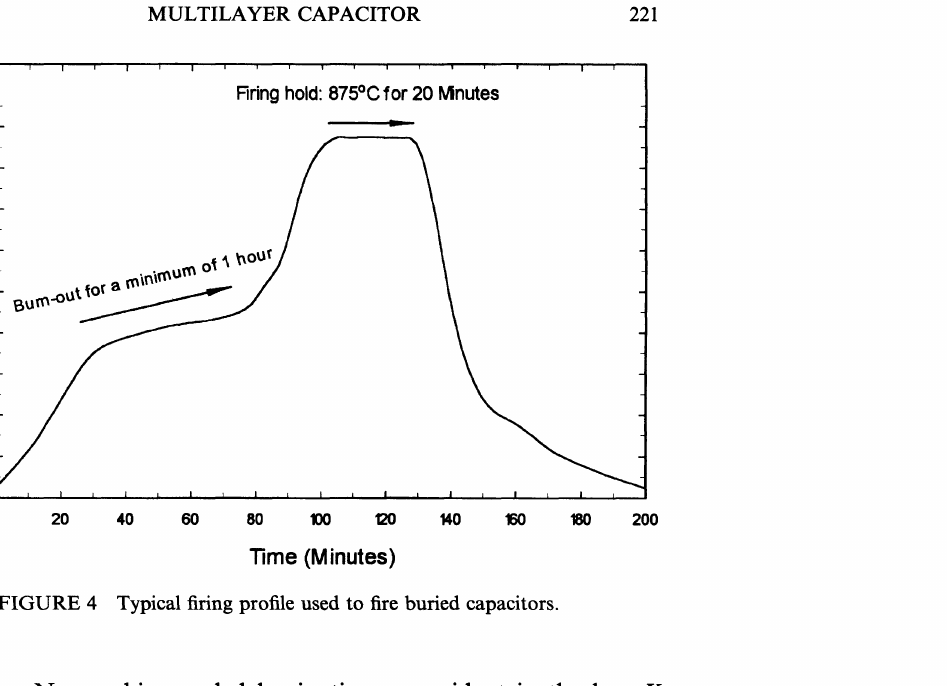
FIGURE 4 Typical firing profile used to fire buried